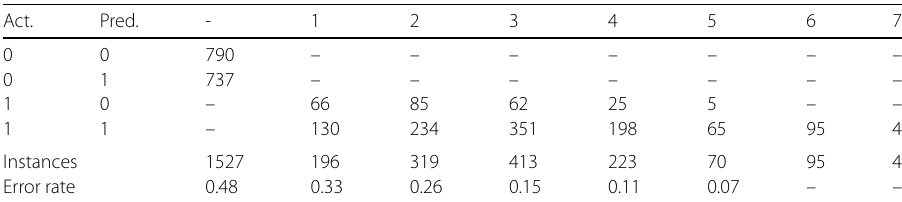
Table 7 Testing performance according to the actual Mercalli intensity for the region of interest detection task. A 0/1 classifier is sufficient for medium and high energy events at municipality level, showing good performance in terms of recall